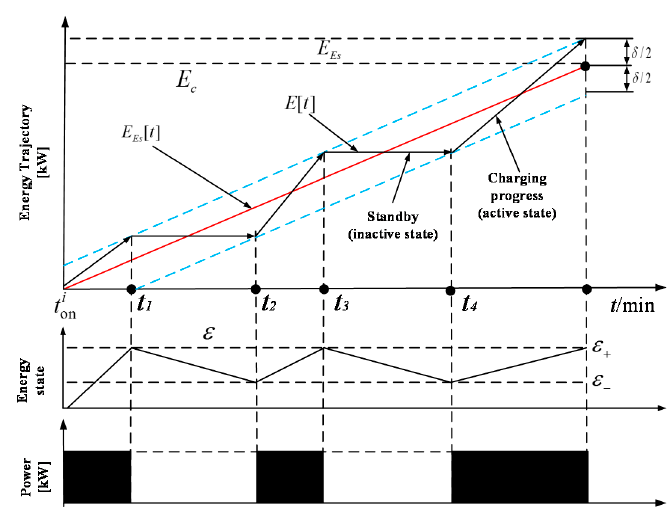
Figure 1. Schematic diagram of hysteresis control for the electrolyzer charging process and sampled energy state comparison.